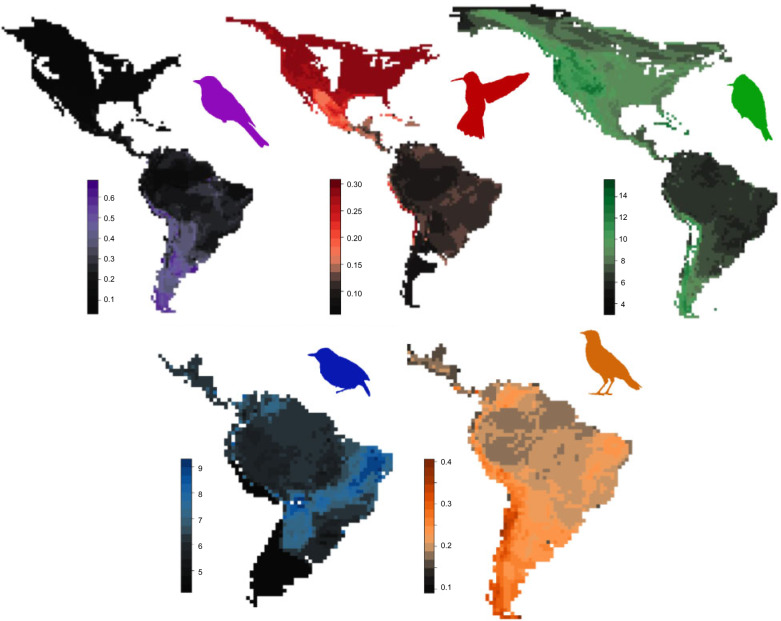
Regional diversification. Present-day diversification tends to be fast in regions with low richness (esp. in the temperate) and slow across the species-rich regions (esp. in the tropics). The pattern is consistent across the five taxa examined. Taxon-specific silhouettes and color-coding correspond with the preceding figures. Maps indicate mean diversification rate of the species occurring across regions (\documentclass[12pt]{minimal}
\usepackage{amsmath}
\usepackage{wasysym}
\usepackage{amsfonts}
\usepackage{amssymb}
\usepackage{amsbsy}
\usepackage{upgreek}
\usepackage{mathrsfs}
\setlength{\oddsidemargin}{-69pt}
\begin{document}
}{}$1 \times 1$\end{document} degree grid cells) covering the New World.